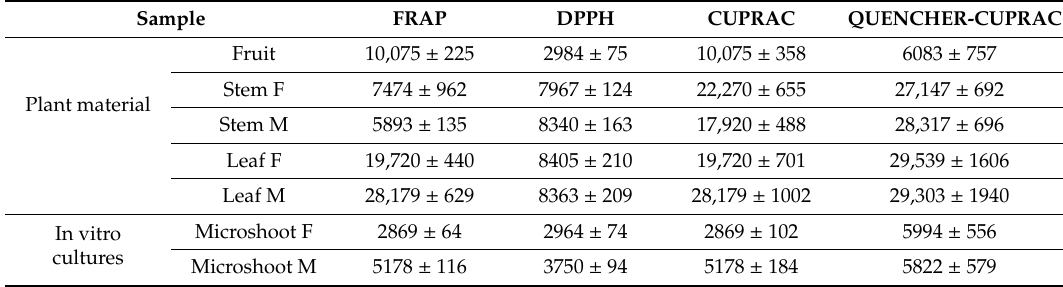
Table 7. Antioxidant potential of plant material determined by Ferric-Reducing Antioxidant Power (FRAP), 2,2-Diphenyl-1-Picryl-Hydrazyl-Hydrate (DPPH), Cupric-Reducing Antioxidant Capacity (CUPRAC) and QUick, Easy, New, CHEap, and Reproducible CUPRAC (QUENCHER-CUPRAC) assays. Antioxidant response was expressed as TE in mg / 100 g DW ± SD; F—female; M—male ( n = 4, p <